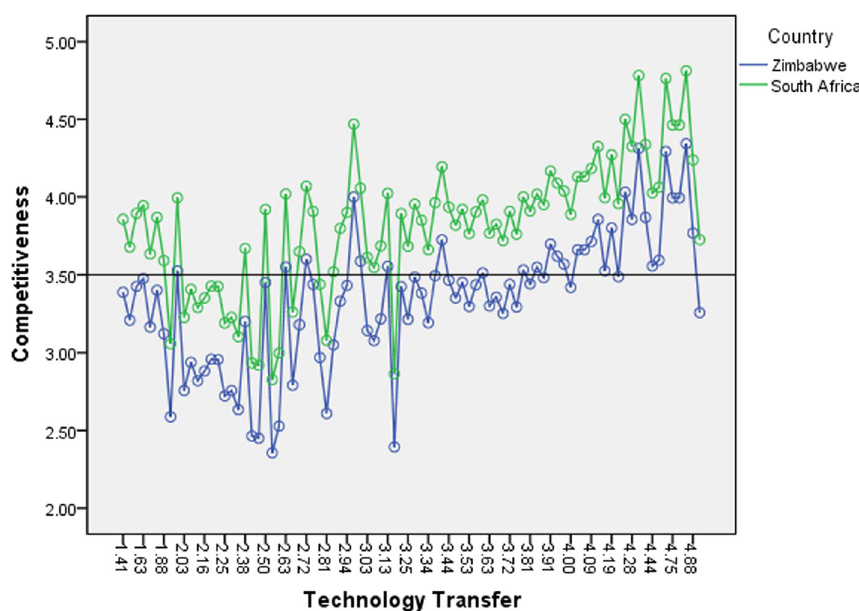
Fig. 4 Country differences of SSABs on competitiveness